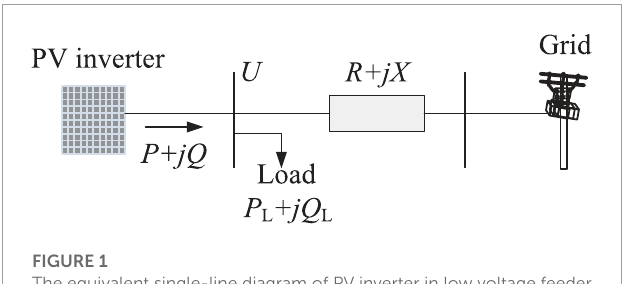
FIGURE 1 The equivalent single-line diagram of PV inverter in low voltage feeder.